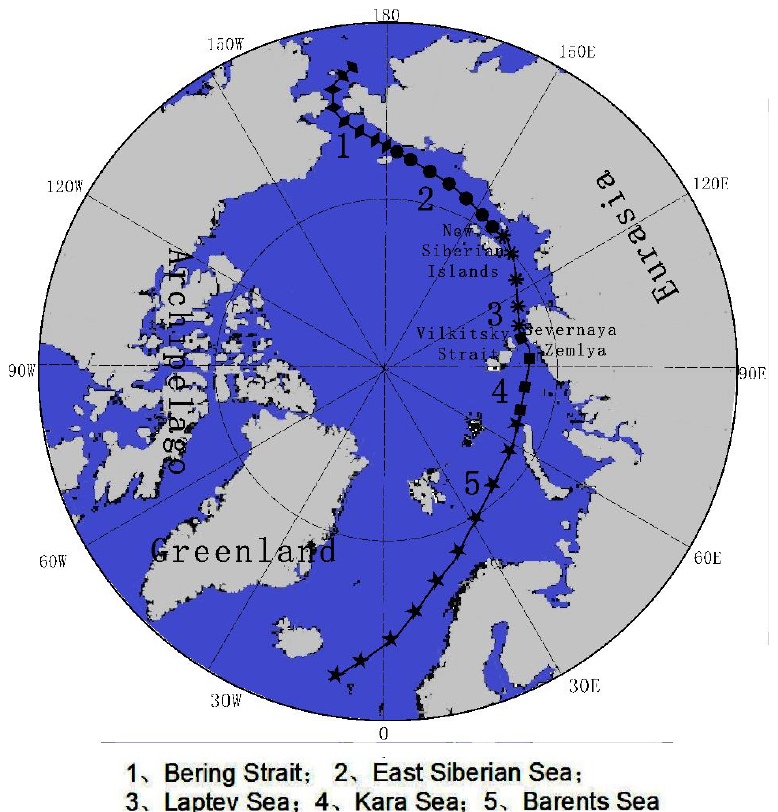
Figure 2. Schematic diagram of the Arctic Northeast Passage (NEP). Table 1. Section division of the NEP.